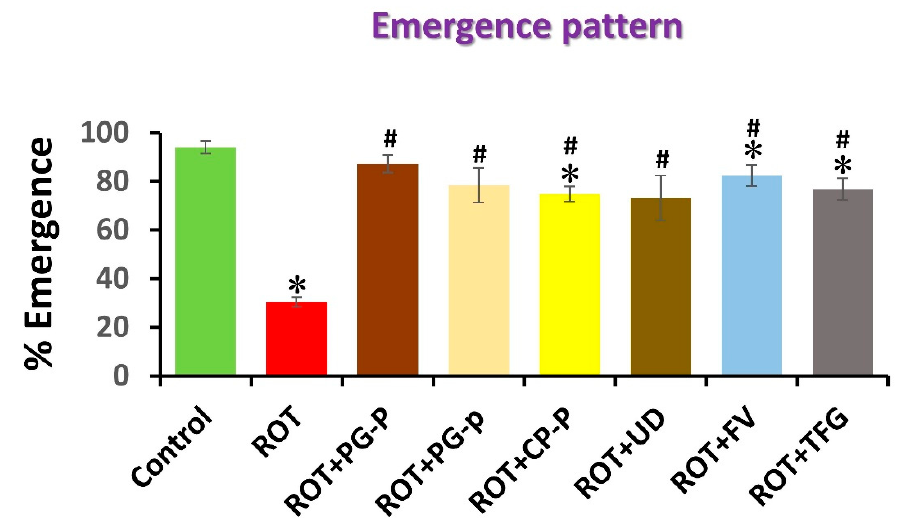
Figure 5. Emergence of flies of Drosophila melanogaster in Oregon R + . All observations are expressed as the mean of 5 vials per group with 50 larvae per vial. Rotenone, ROT; pomegranate peel, PG-P; pomegranate pulp, PG-p; papaya peel, CP-P; nettle leaves, UD; fennel, FV; and fenugreek, TFG. Each observation was performed three times and is shown as the mean ± SEM. Results were significant at p < 0.05. Significance was * p < 0.05 compared to control; # p < 0.05 compared to rotenone.